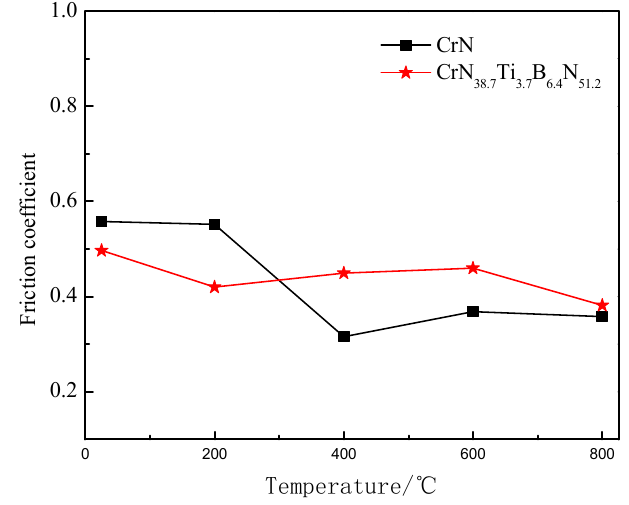
Figure 9. Friction coefficient of CrN film and Cr 38.7 Ti 3.7 B 6.4 N 51.2 composite film at different temperature.